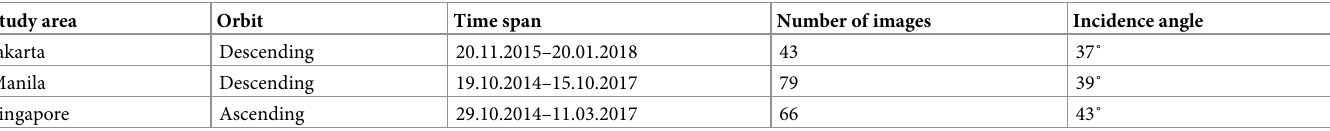
Table 1. Main characteristics of SAR images used in InSAR